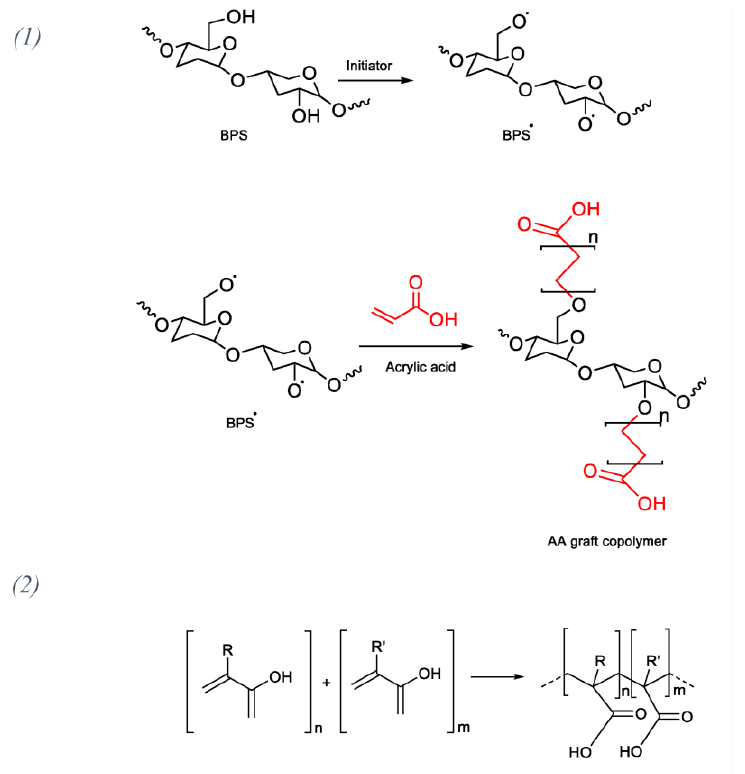
Figure 1. ( 1 ) Possible synthesis of the new BB graft copolymer; ( 2 ) Acrylic acid radical polymeriza- tion.